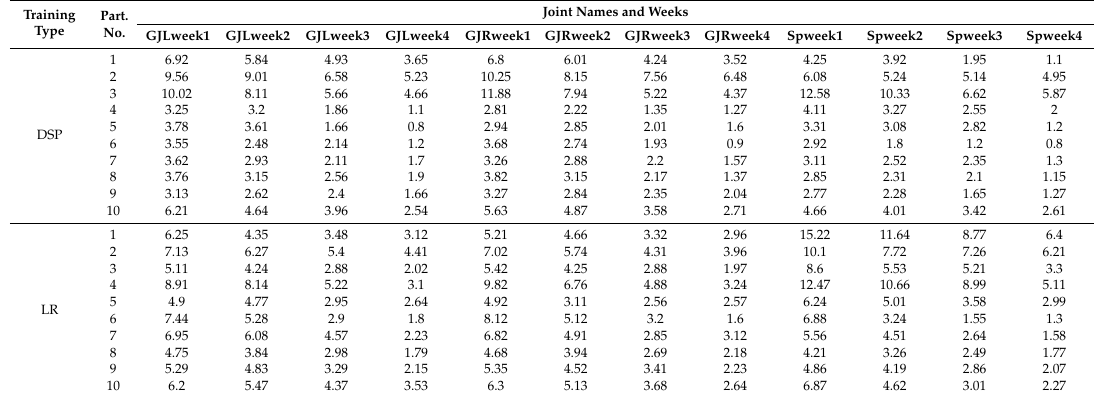
Table A1. Weekly Joint Displacement of